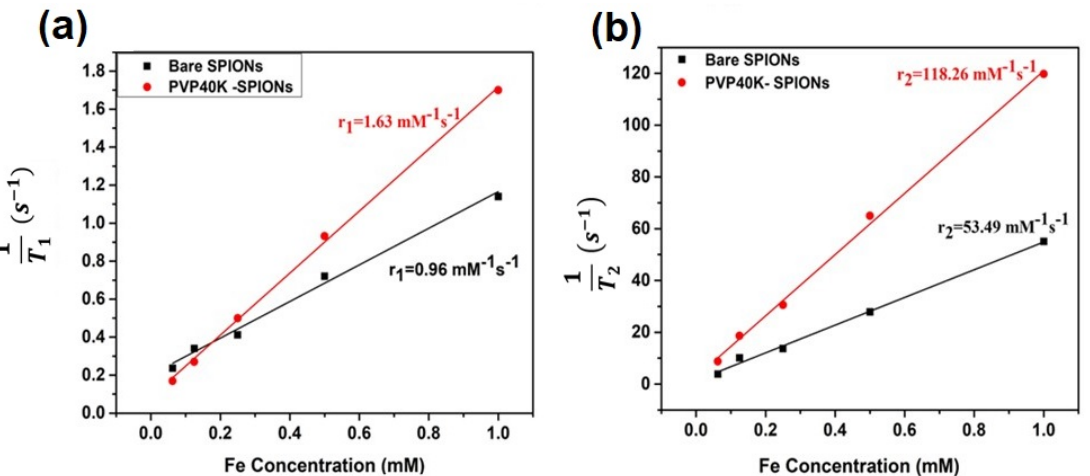
Figure 7. ( a ) Longitudinal relaxation rates (1/T 1 ), ( b ) transverse relaxation rates (1/T 2 ) of bare SPIONs and PVP40K-SPIONs with di ff erent concentrations of iron measured at 1.5 T.